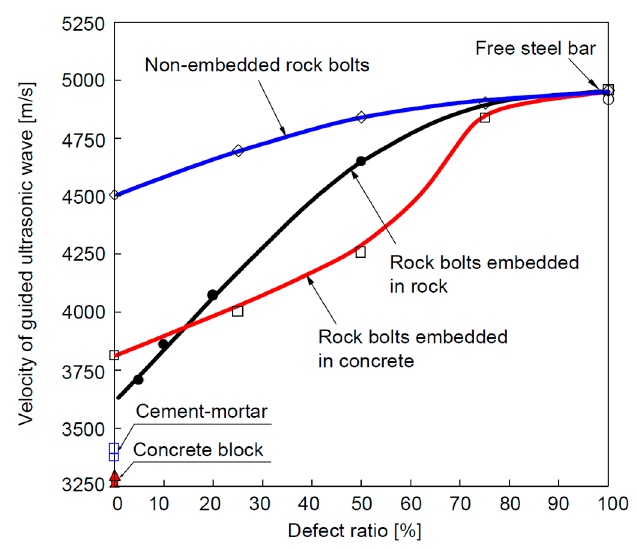
Figure 21. Velocity of guided ultrasonic waves versus the defect ratio (DR) for non-embedded rock bolts, rock bolts embedded in concrete and rock bolts embedded in rock [65]. Note: Velocity of free steel bar V S = 4955 m/s; velocity of cement mortar V M = 3336 m/s; velocity of concrete block V C = 3290 m/s; velocity of rock mass V R ≥ 2700 m/s.